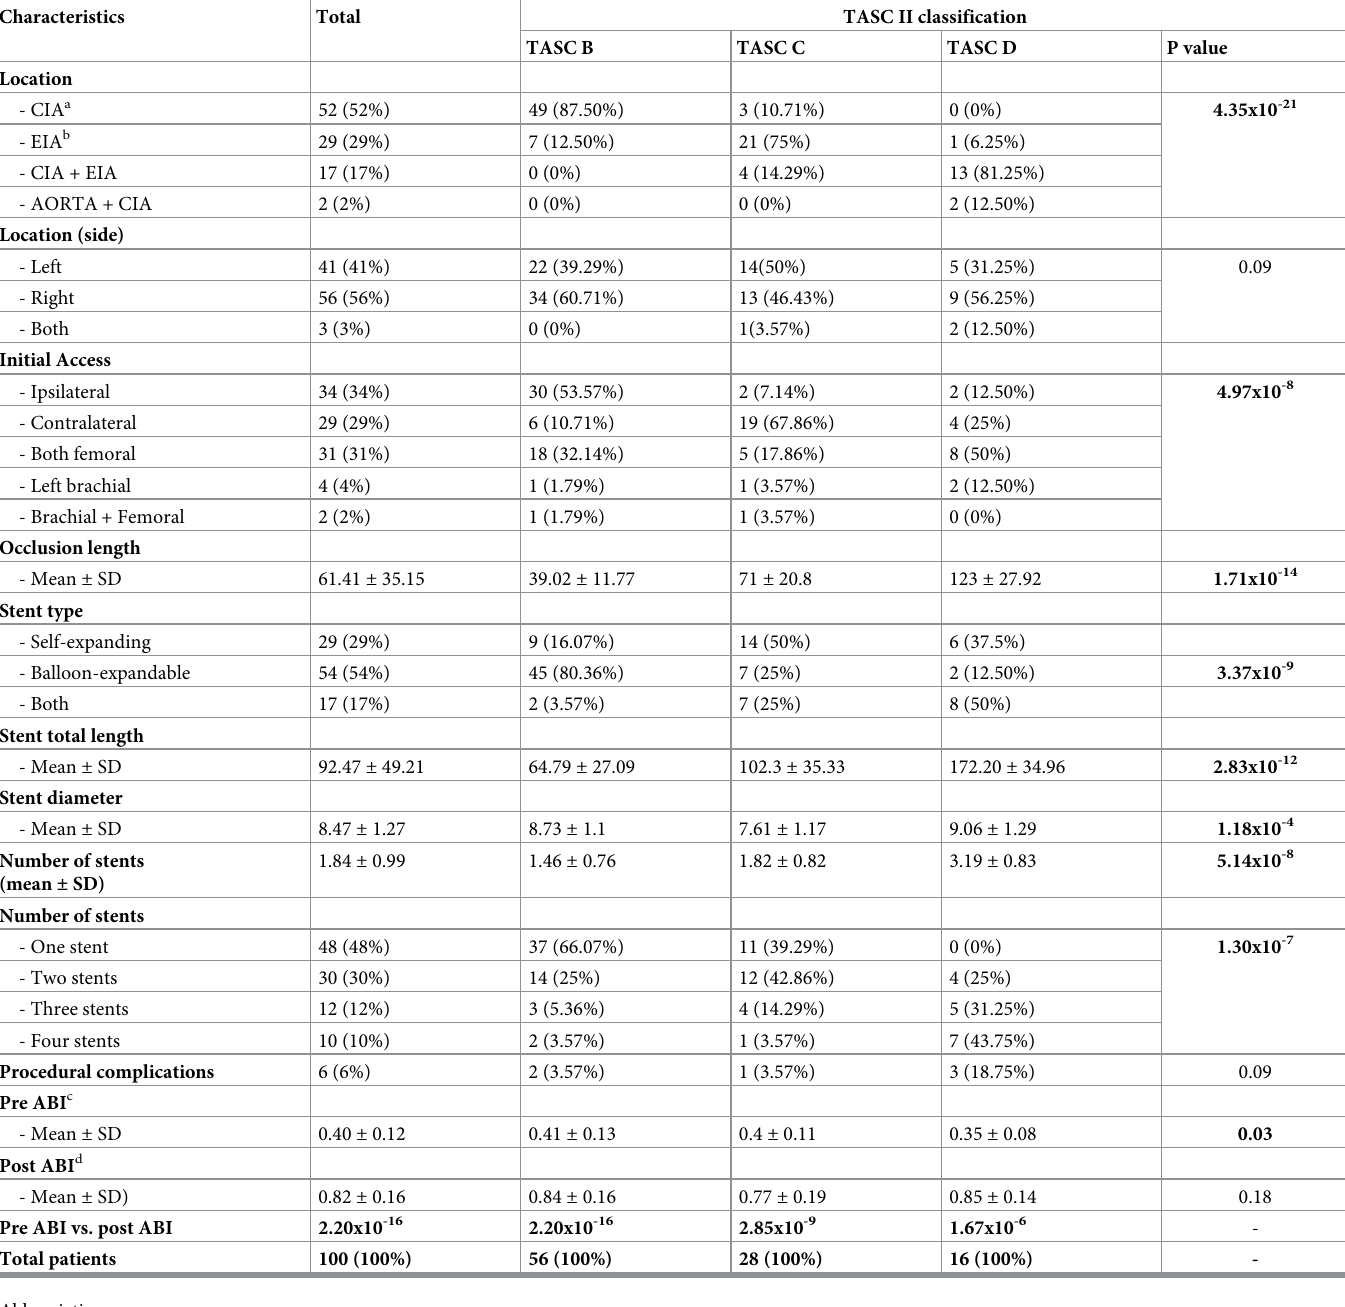
Table 2. Lesion and procedural characteristics: Whole group and according to TASC II classification.